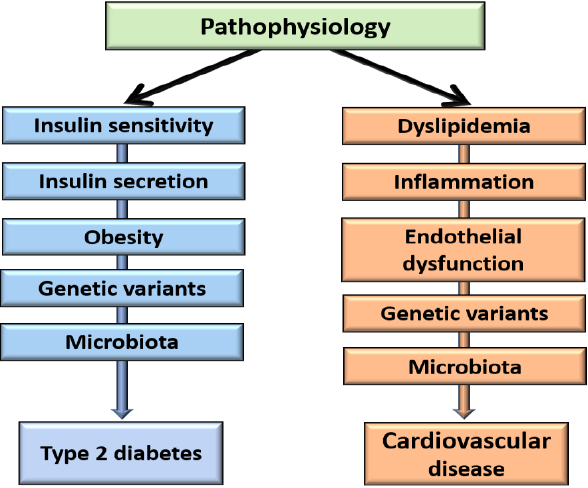
Figure 1. Pathophysiology of type 2 diabetes and cardiovascular